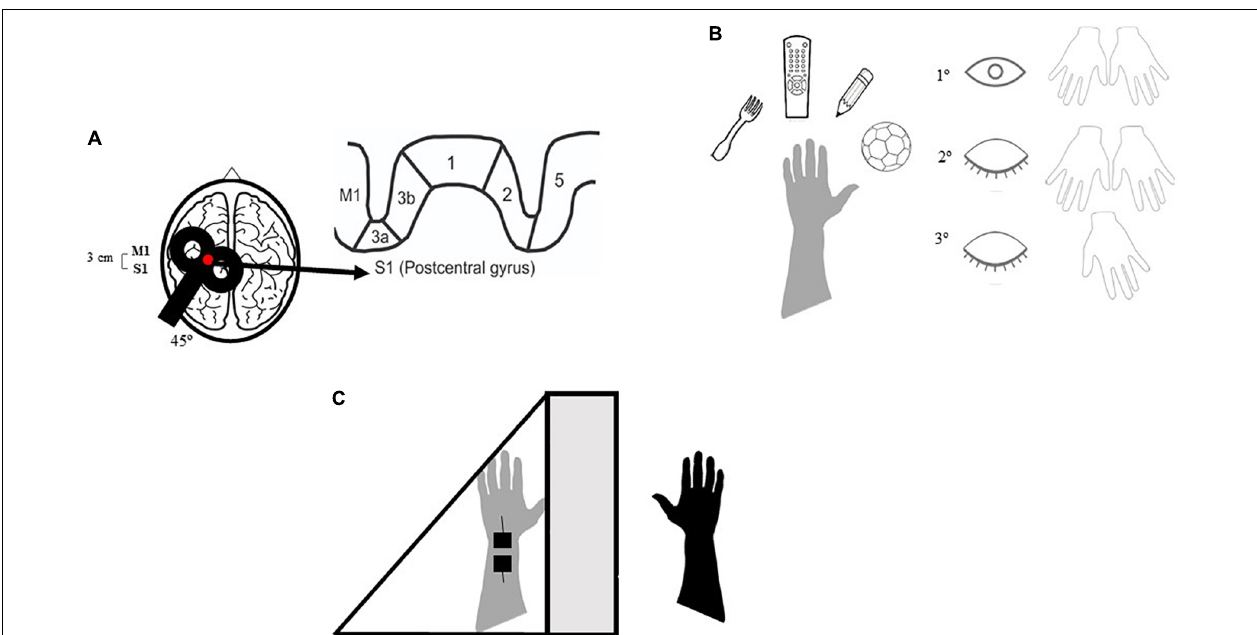
FIGURE 2 | Demonstration of the therapeutic environment of repetitive transcranial magnetic stimulation (rTMS) and sensory stimulation. M1, primary motor cortex; S1, primary somatosensory córtex. Participants who were part of the active rTMS/SS group received 20 min of rTMS over S1 followed by the active sensory training: the participant has to haptically explore different textures of familiar objects and to recognize their different characteristics. First with both hands (intramodal calibration) and eyes open (cross-modal calibration) then using only the affected hand and eyes closed (Carey et al., 2011). Firstly, we required to explore the object with eyes closed and both hands, then with only the affected hand and eyes closed. The final part of the training consisted in Mirror Therapy in addition to transcutaneous electrical nerve stimulation (TENS). (A) rTMS on S1, 20 min. (B) Active sensory training, 20–25 min. (C) Mirror therapy/TENS, 40–45